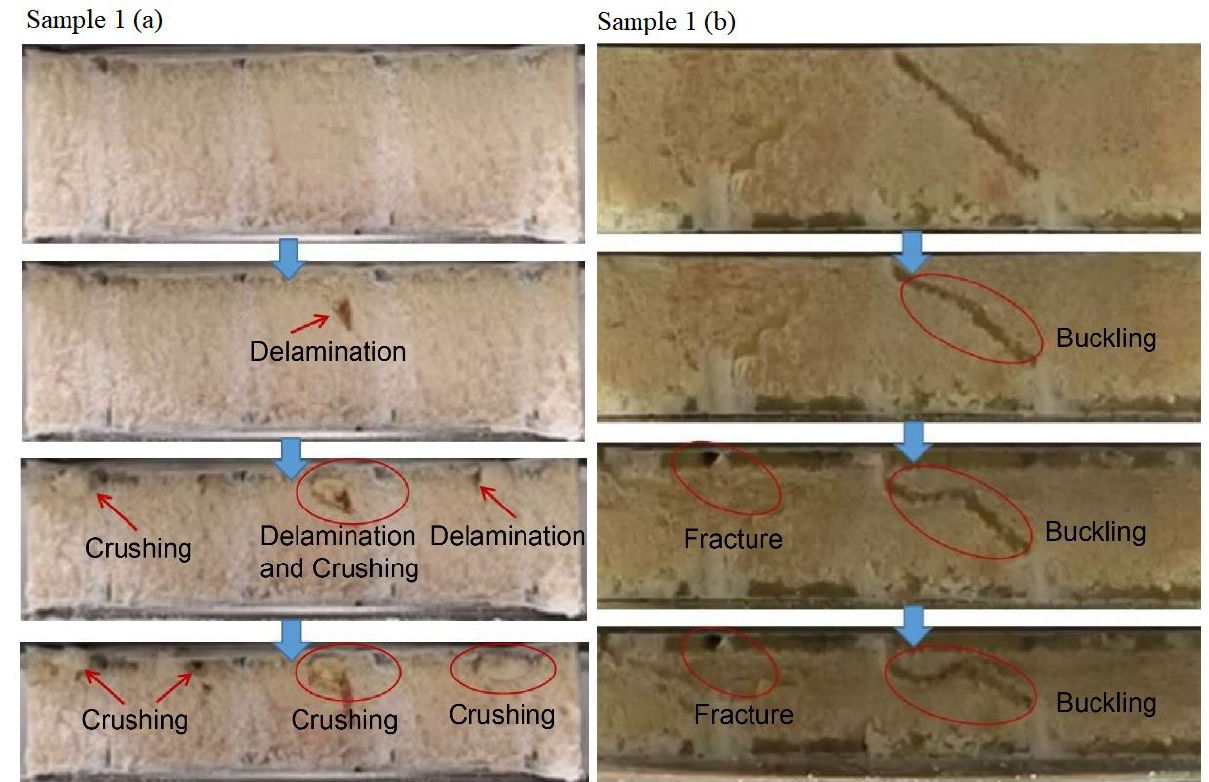
Figure 21. Side images demonstrating crack failure of the flat compression samples ( a ) and samples ( b ) after the flat compression test.